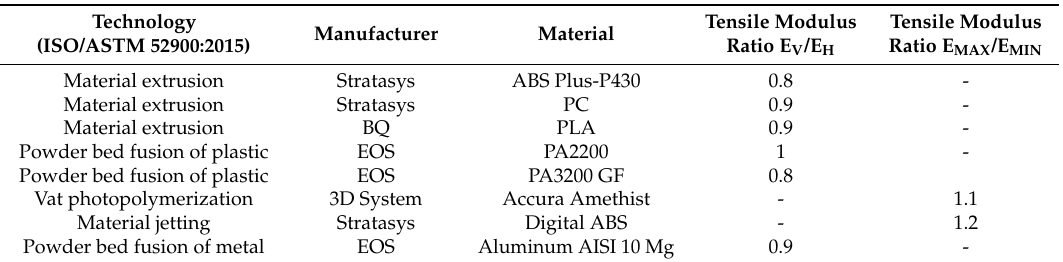
Table 1. Anisotropy factors in some commercial materials according to technical data sheets. EV: direction ZXY, EH: direction